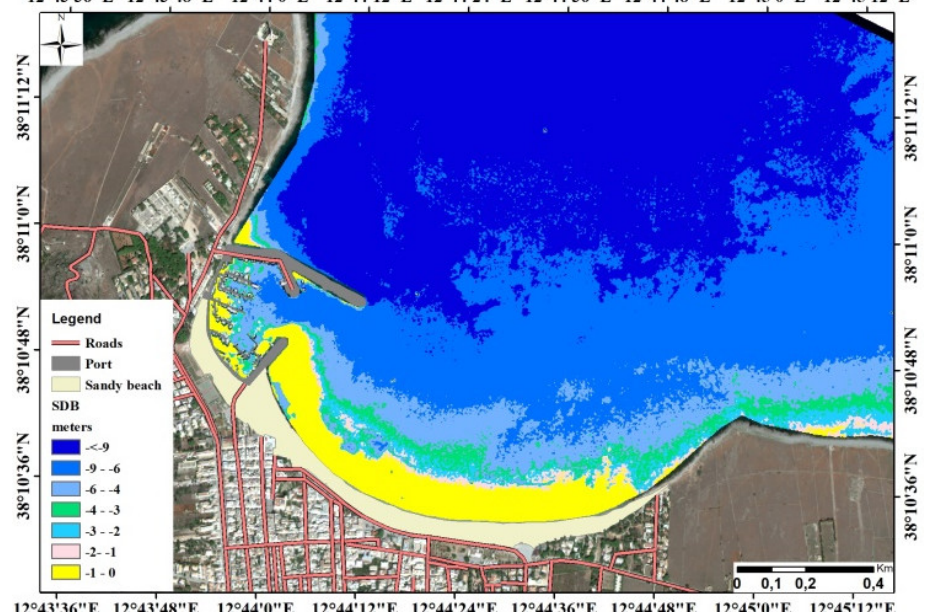
Figure 10. SDB (satellite-derived bathymetry) extracted on the GeoEye-1 satellite image acquired on 18 October 2014 on the coast of San Vito Lo Capo.